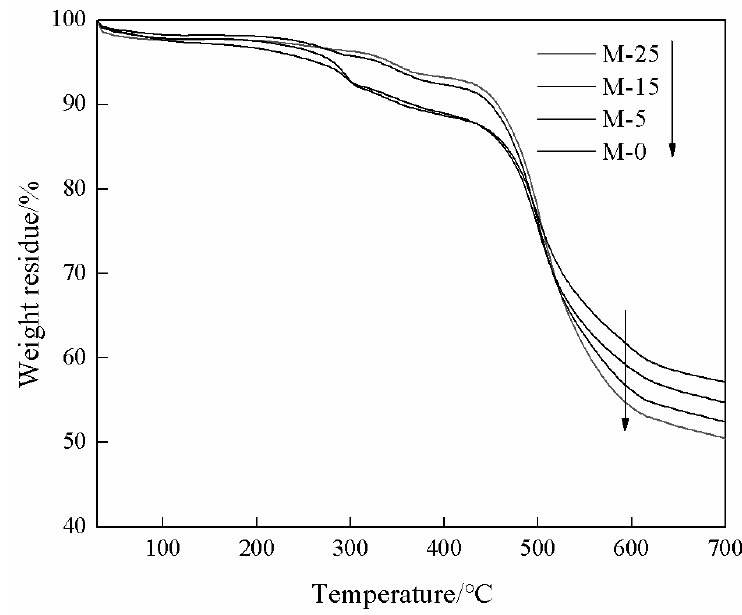
Figure 7. TGA curves of the mixed matrix membranes.